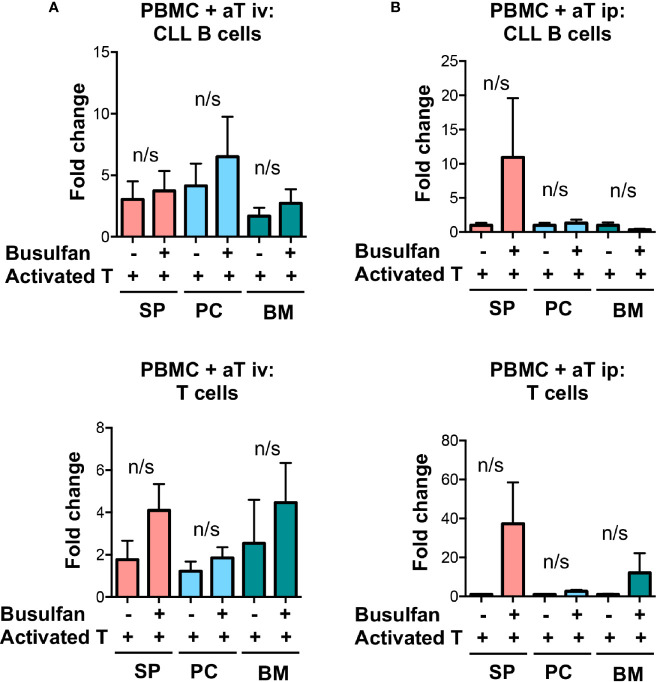
Busulfan preconditioning does not provide a clear advantage for the xenografting of primary CLL cells in the PBMC + aT model. (A) Five NSG mice did not or did receive 25mg/kg busulfan ip 24 h prior to xenografting. Then, 20 × 106 CLL PBMCs with 0.5 × 106 activated T cells (aT) were injected iv into NSG mice. Five weeks after cell injection, mice were sacrificed and single cell suspensions from blood, spleen, bone marrow (BM) and peritoneum were analyzed by flow cytometry. Busulfan did not significantly improve CLL B-cell (top) and T-cell (bottom) engraftment. Data represent a composite of experiments involving cells from 4 patients, 2 U-CLL and 2 M-CLL. (B) Similar busulfan preconditioning was given or not to two other sets of 5 NSG mice that received samples from 4 different patients (2 U-CLL and 2 M-CLL). Twenty-four h after, 20 × 106 CLL PBMCs with 0.5 × 106 activated T cells (aT) were injected ip into each recipient mouse. Although there is a trend for better engraftment of CLL B and T cells in busulfan-pretreated mice, there are no significant differences between the numbers of CLL B and T cells in any of the groups. Bar graphs represent the mean fold change (after setting the average cell counts obtained from PBMC mouse spleens as 1); S.E.M. determined by Mann-Whitney U test. n/s: no statistically significant difference.